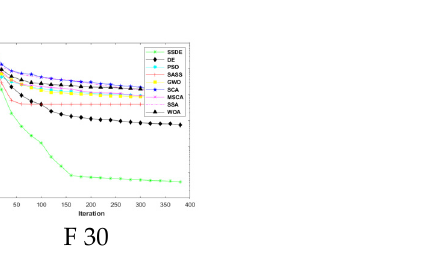
Figure 4. Evolutionary curves of SSDE, DE, PSO, SASS, GWO, SCA, MSCA, SSA, and WOA on the CEC 2017 test functions in 10 dimensions.